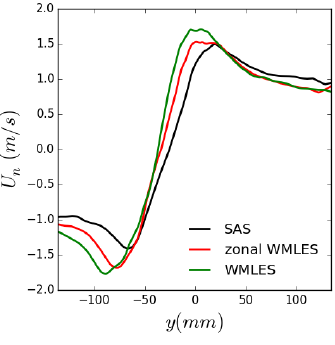
Figure 11. Phase-averaged distribution of the normal velocity over Line 1, for time instance B in Figure